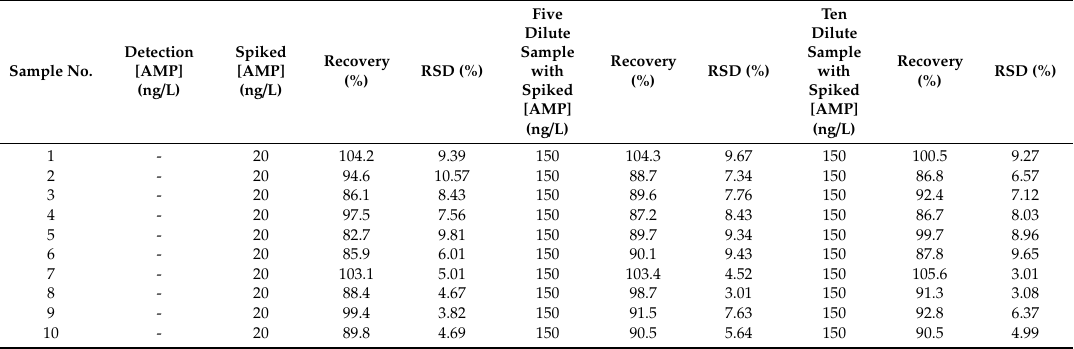
Table 2. The AMP detection from hospital wastewaters by the developed method.